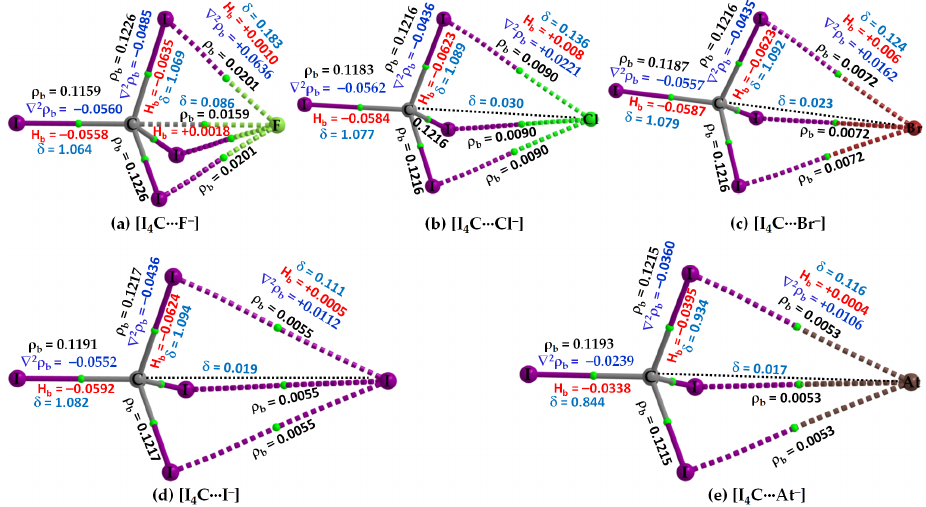
Figure 4. ( a – e ) [ ω B97X-D/def2-QZVPPD] level QTIM-based molecular graphs of [I 4 C ··· X − ], showing the bond paths (solid and dotted lines in atom color) and bond critical points (tiny spheres in green) between bonded atomic basins. Large spheres represent the atomic basins. The dotted black line in ( b – e ) is artificially drawn to represent the presence of tetrel bond between C and X (X = Cl, Br, I, At). The charge density ( ρ b ), the Laplacian of the charge density ( ∇ 2 ρ b ), the total energy density (H b ), and the delocalization index ( δ ) values are shown in black, blue, red, and faint-blue fonts (in a.u.), respectively. Molecules 2022 , 27 , x FOR PEER REVIEW